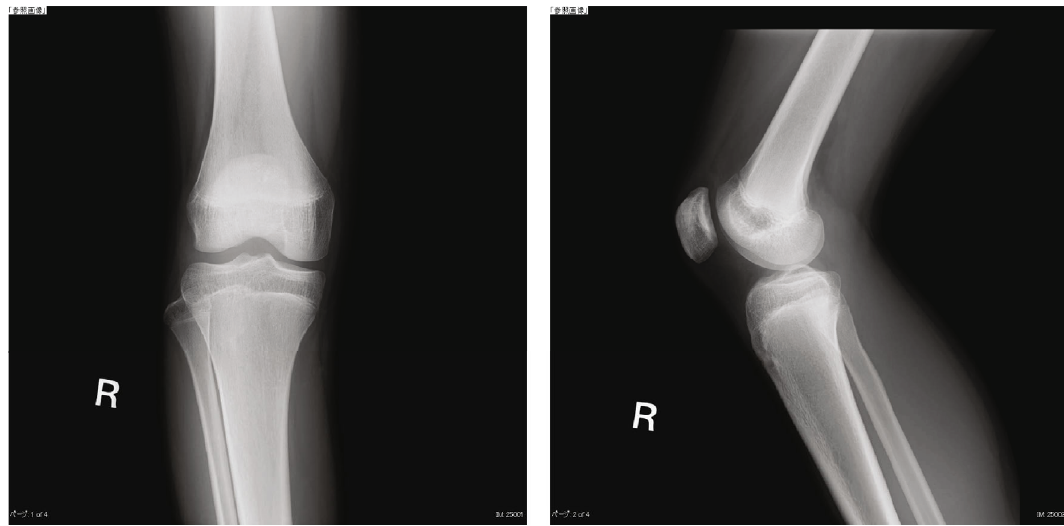
Figure 1: Plain radiography reveals no abnormal fi ndings.